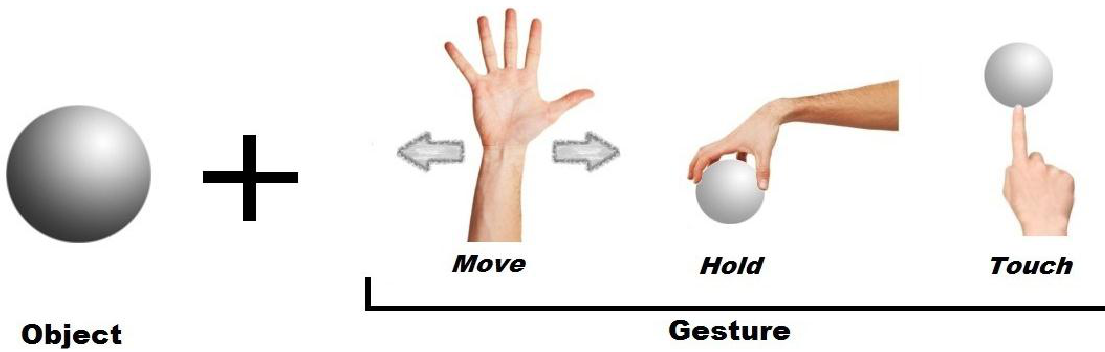
Figure 1. The Tangible Gesture Interaction Framework (TGIF) syntax of tangible gestures: a gesture based on optional move, hold and touch components, related to one